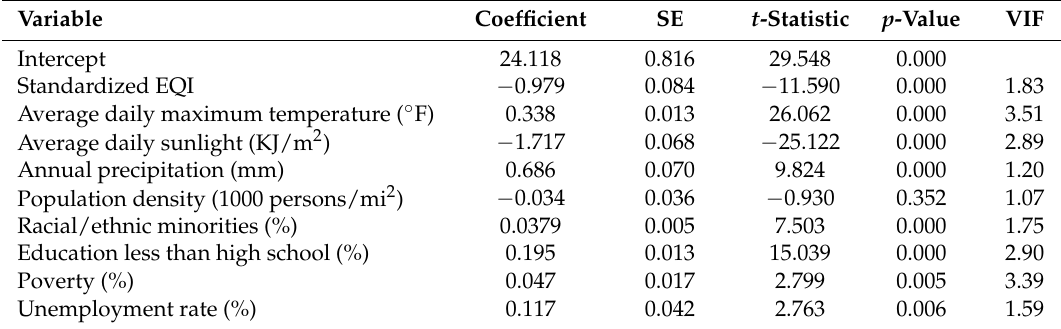
Table 2. Estimated effect of overall environmental quality index (EQI) on county-level prevalence of physical inactivity using OLS.